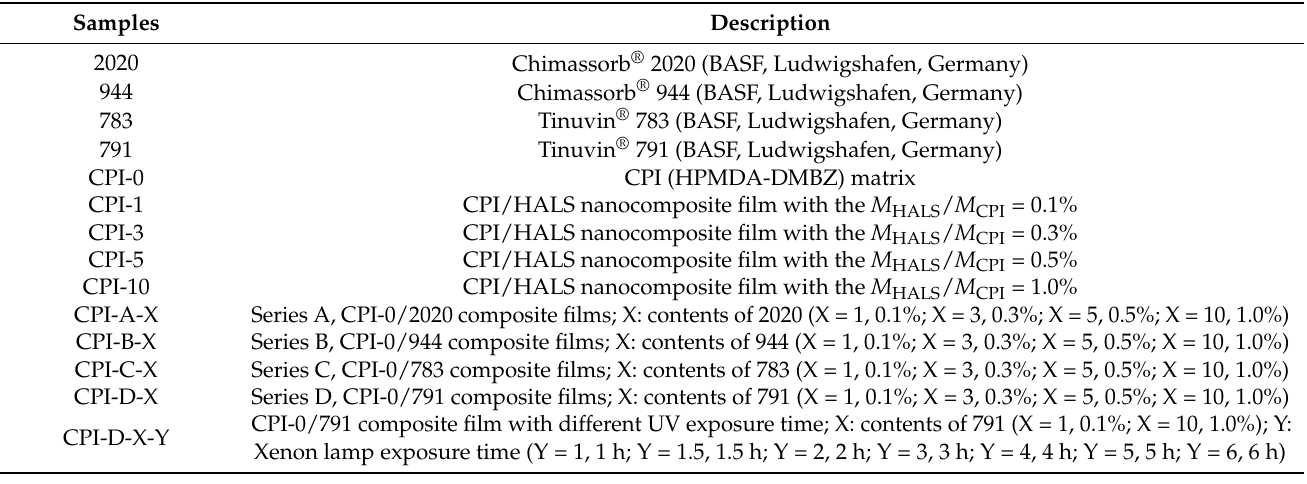
Table 2. Abbreviation and description of the CPI samples in the current work.